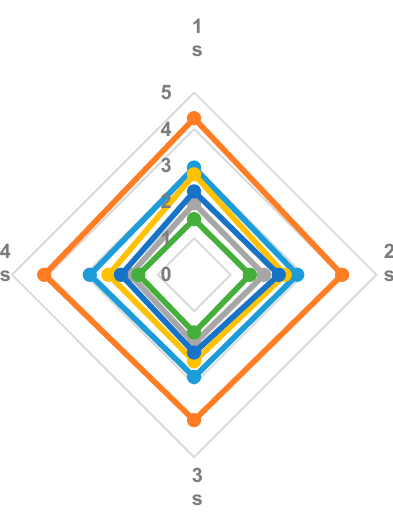
Figure 8. System performance for laying on bed position over a stipulated timeframe.